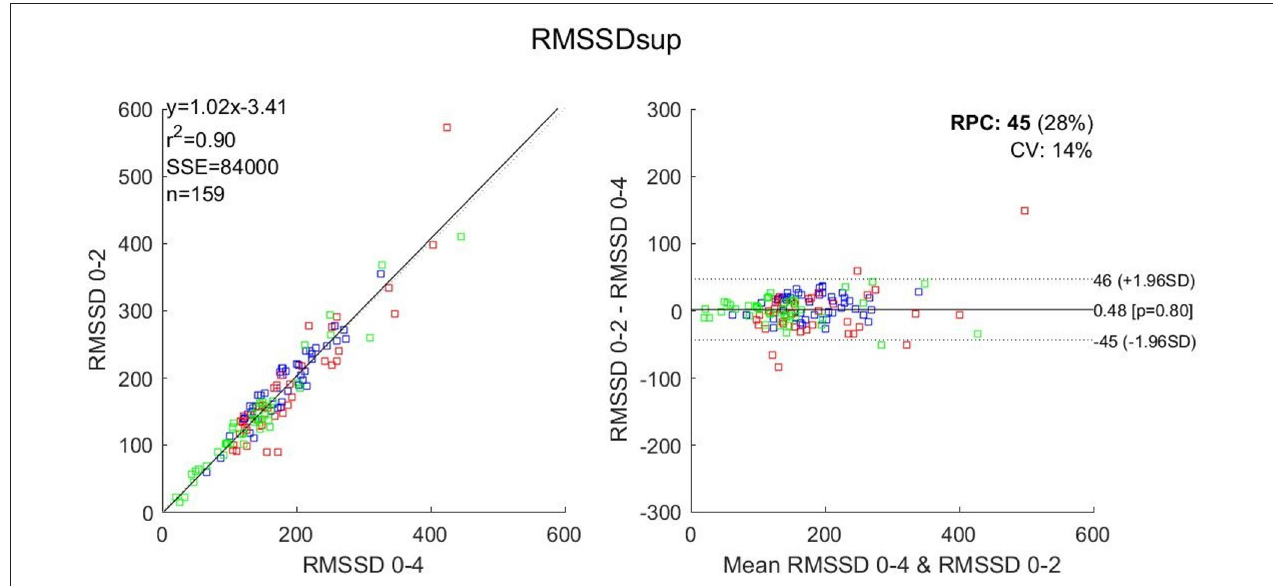
FIGURE 3 | Correlation (Left) and Bland and Altman (Right) plots for comparison of RMSSD in the 0–2 and the reference 0–4 windows in the supine position. r 2 , Pearson r square; SSE, sum of square error; RPC, reproducibility coefficient; CV, coefficient of variation. Blue dots: Subject 1; red dots Subject 2; green dots: Subject